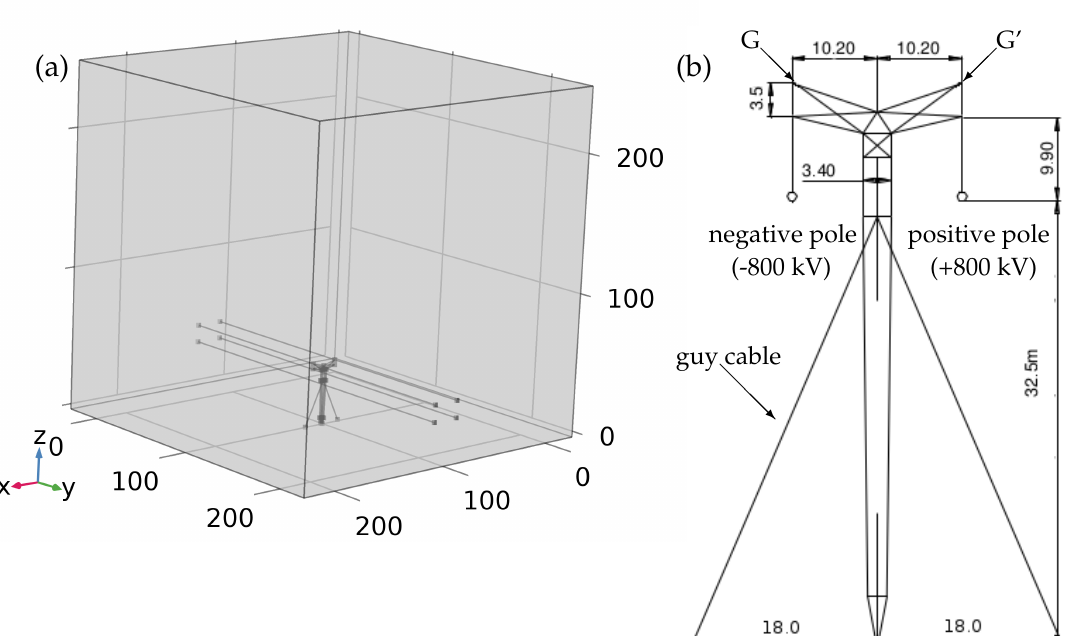
Figure 3. ( a ) Domains containing a HVDC line segment with a guyed tower. Coordinates x , y and z are given in metres ( b ) Dimensions in metres of the guyed tower. G and G’ are the arrestor cables.